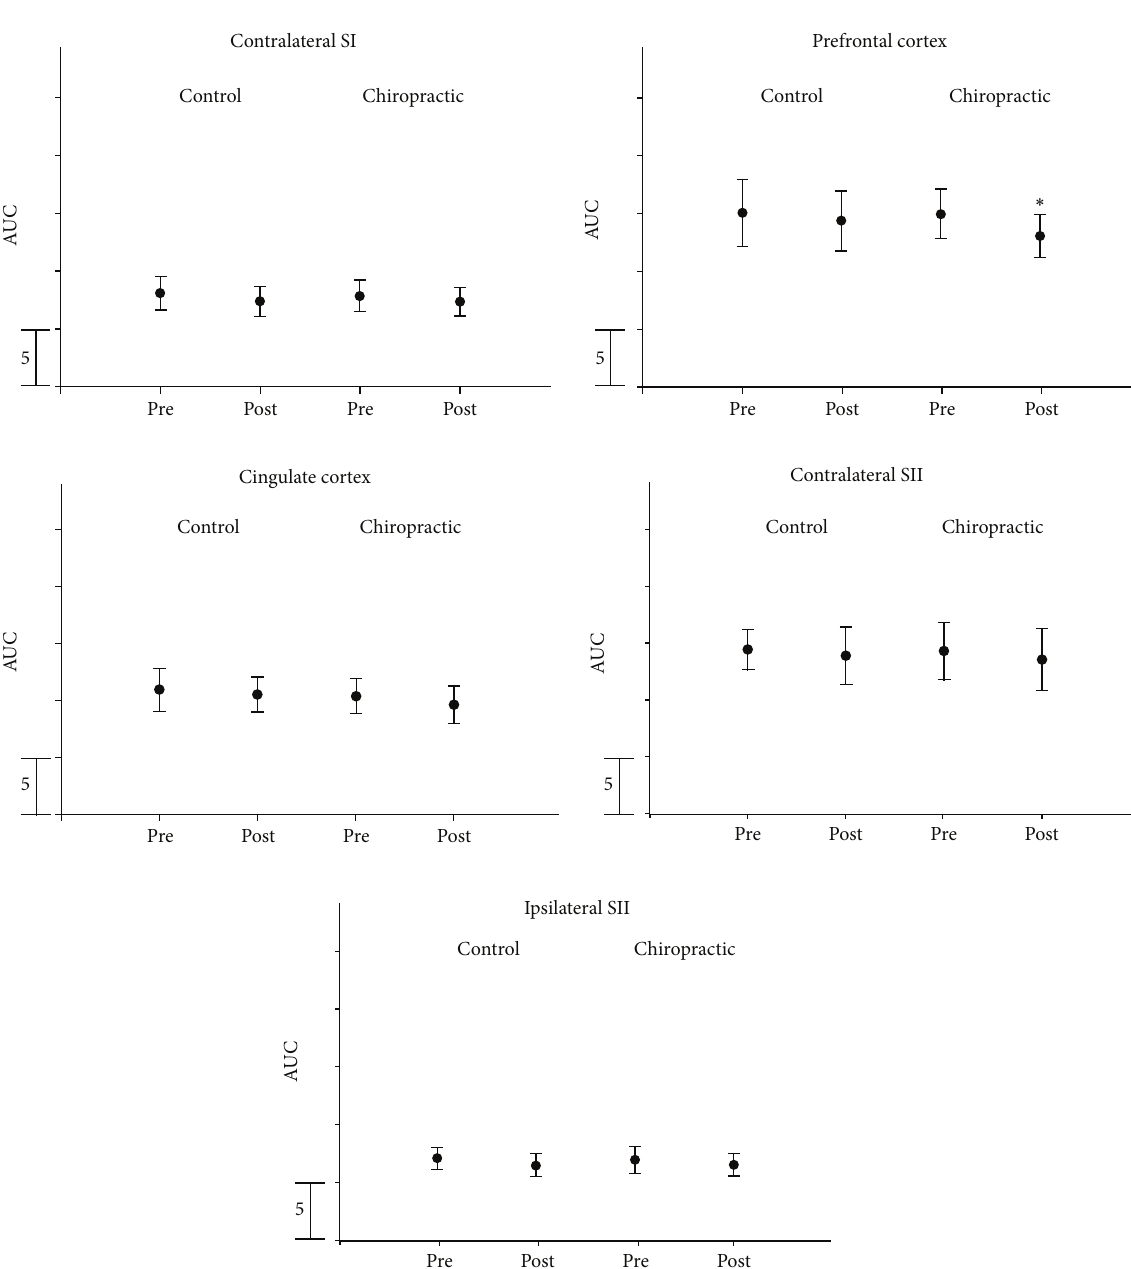
Figure 3: AUC error bars for each of the sources. ∗ represents significant